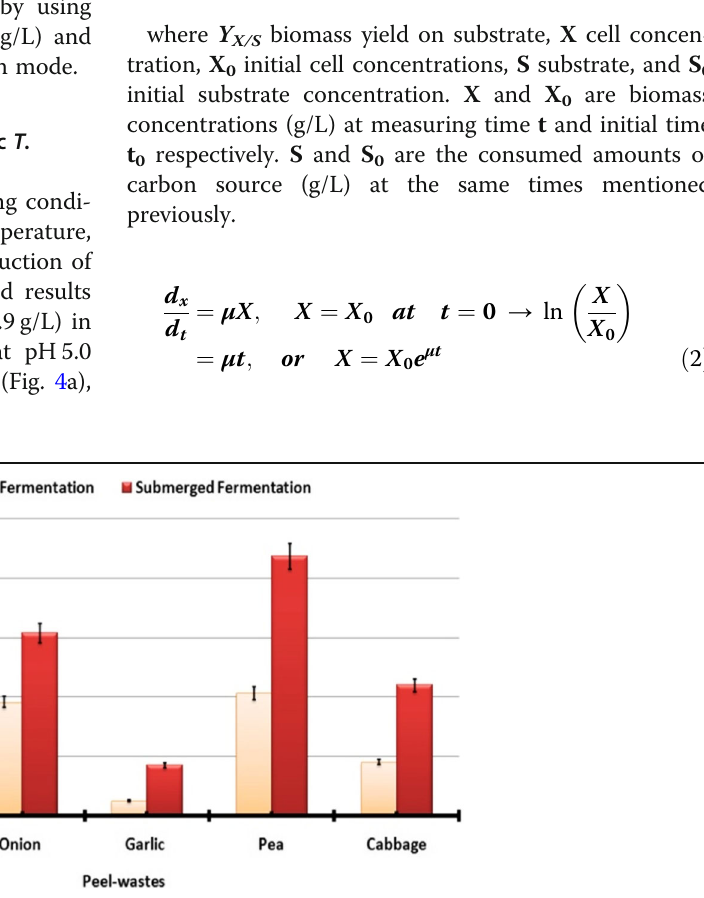
Fig. 2 Effects of different waste peels on the produced biomass dry weight of endophytic T. harzianum cultivated by using submerged and solid-state